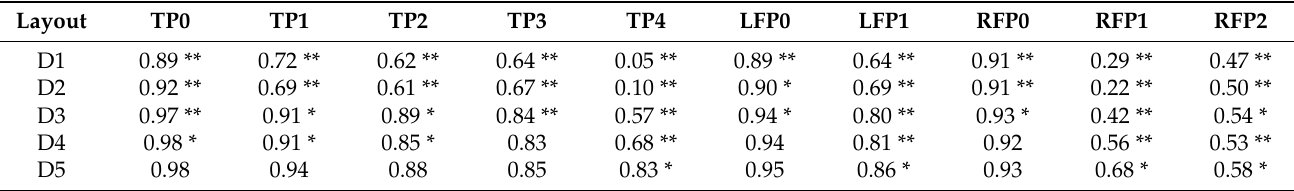
Table 3. F1 score for each posture class based on new sensor